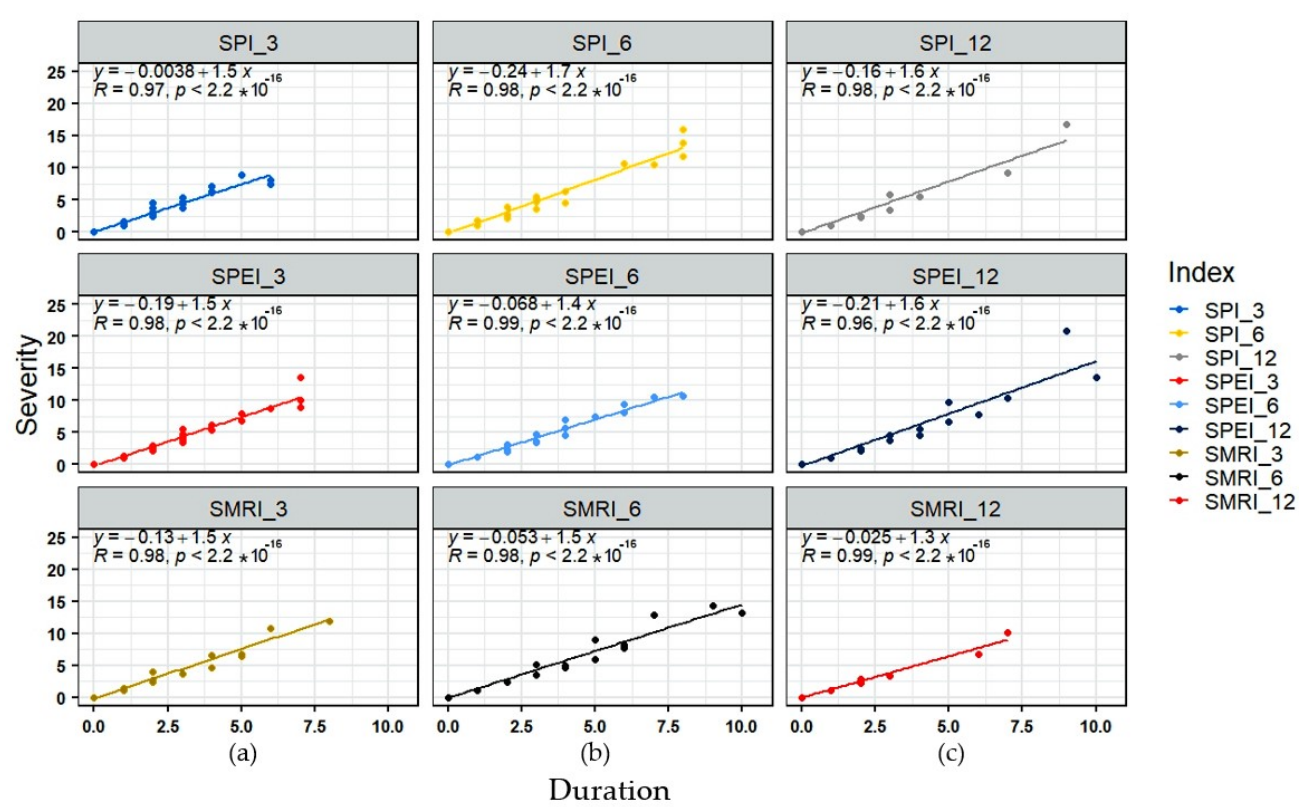
Figure 10. Drought Severity (DS) over ULB using SPI, SPEI and SMRI indices,1981 to 2018 . ( a ) 3_months, ( b ) 6_months and ( c ) 12_ months.